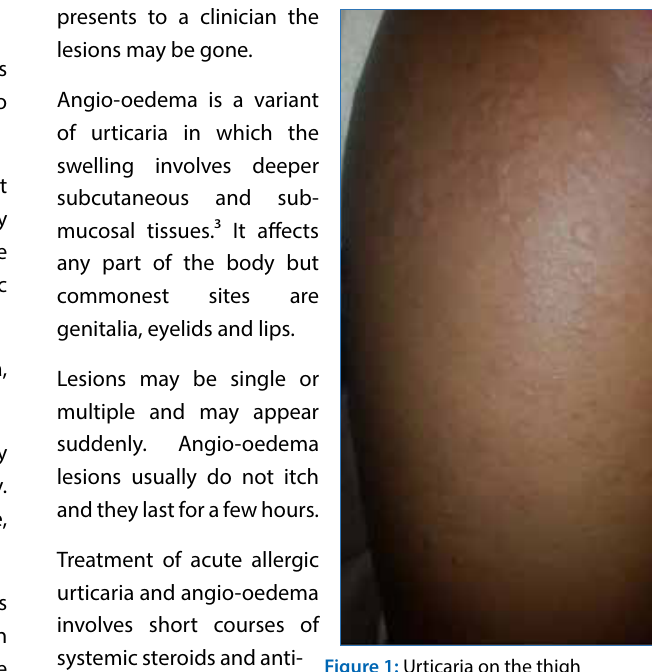
Figure 1: Urticaria on the